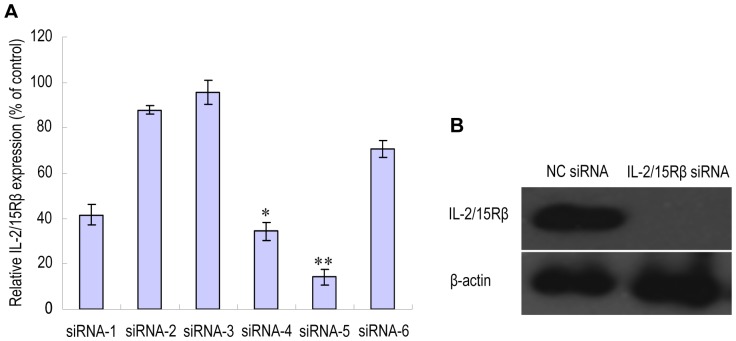

In vitro validation of siRNA sequences designed to target rat IL-2/15Rβ.Six different IL-2/15Rβ siRNA sequences were designed and rat peritoneal macrophages were transfected with each of the six siRNA duplexes or with a nontargeting negative control siRNA (NC siRNA) using X-tremeGENE siRNA transfection reagent (Roche). RNA and proteins were prepared at 24 and 48 h post-transfection, respectively. (A) IL-2/15Rβ mRNA levels measured by quantitative real time-PCR (qPCR). Results were normalized to GAPDH and are presented as the percentage of NC siRNA. *P<0.05; **P<0.01 versus NC siRNA. (B) Western blot analysis of IL-2/15Rβ protein levels in macrophages transfected with siRNA-5. The detection of actin expression was performed to monitor protein loading.